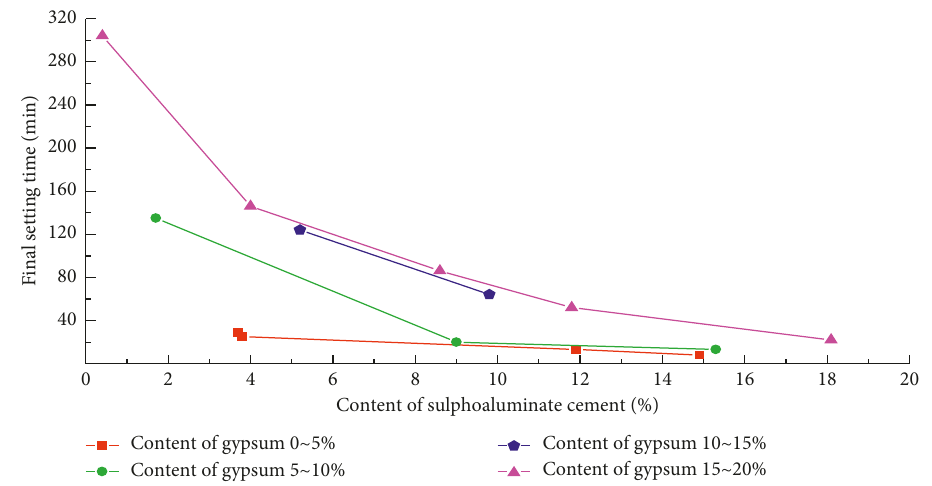
Figure 6: Relationship between final setting time and components of composite cementing